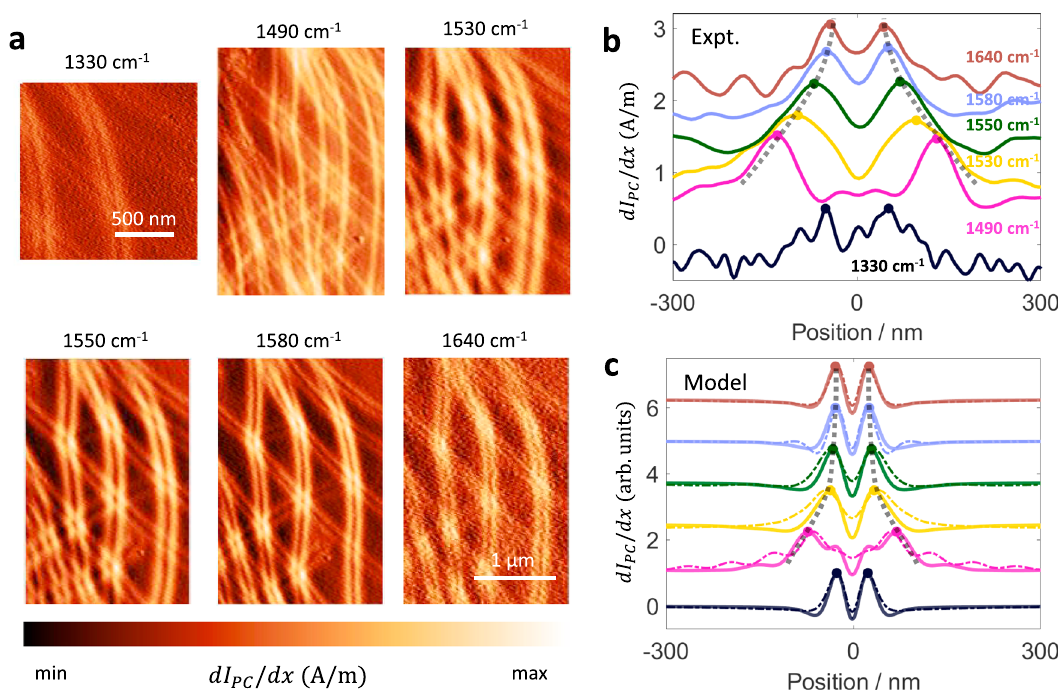
Fig. 3 Domain wall photocurrent patterns in the hBN Reststrahlen band. a Gradient of photocurrent (d I PC /d x ) for several frequencies around the hBN Reststrahlen band. b Experimental line pro fi les of d I PC /d x for several frequencies. The black dashed lines are guides to the eye. c Photocurrent pro fi les calculated using the frequency-dependent electric fi eld pro fi les. The thick solid lines correspond to the hyperboloid tip and the thin dashed lines correspond to the point dipole model. The theoretical curves are normalized to their respective maxima. Curves in panel b and c are offset vertically for clarity.